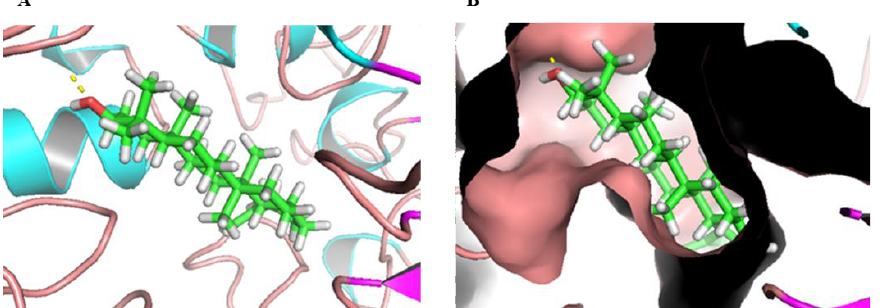
Figure 3. Molecular docking of BA with α -glucosidase. ( A ) Three-dimensional diagram of the interaction between BA and the binding pocket of α -glucosidase. ( B ) The receptor surface model of α -glucosidase with BA. BA was inserted into the hydrophobic cavity of α -glucosidase (light blue) in the surface structure; the yellow dashed line represents the hydrogen bond. The atoms of BA were color-coded as follows: C, green; H, white; O, red.